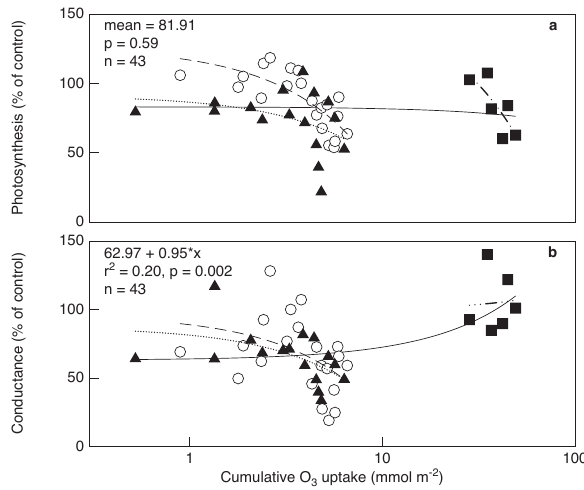
Fig. 9. The correlation of photosynthesis (a) and stomatal conduc- tance (b) to CUO from all studies that measured responses of wheat plants grown in pots exposed to 100ppbO 3 in growth chambers and compared to control plants exposed to charcoal-filtered air. CUO is shown on a log scale, but linear analyses ( r 2 and line equa- tions) were performed on non-log transformed data. Different sym- bols represent different studies. Initial data considered (open circles and dashed line) were from a single study and demonstrated nega- tive correlations between CUO and both photosynthesis ( r 2 = 0 . 59, p < 0.001) and conductance ( r 2 = 0 . 19, p =0.05). Adding data from other studies measuring the responses of wheat plants to O 3 in similar environments (closed symbols) resulted in no overall cor- relation with CUO, though overall correlations exist in some indi- vidual studies (photosynthesis: triangles and dotted line, r 2 = 0 . 15, p =0.15; squares and dot-dashed line, r 2 = 0 . 61, p =0.06; conduc- tance: triangles and dotted line, r 2 = 0 . 28, p =0.03; squares and dot-dashed line, r 2 = 0 . 004, p =0.91). The text in the figure and the solid regression line summarizes the information for all data points included in the figure. r 2 values are only included for overall significant correlations, and n values are the number of data points included in the